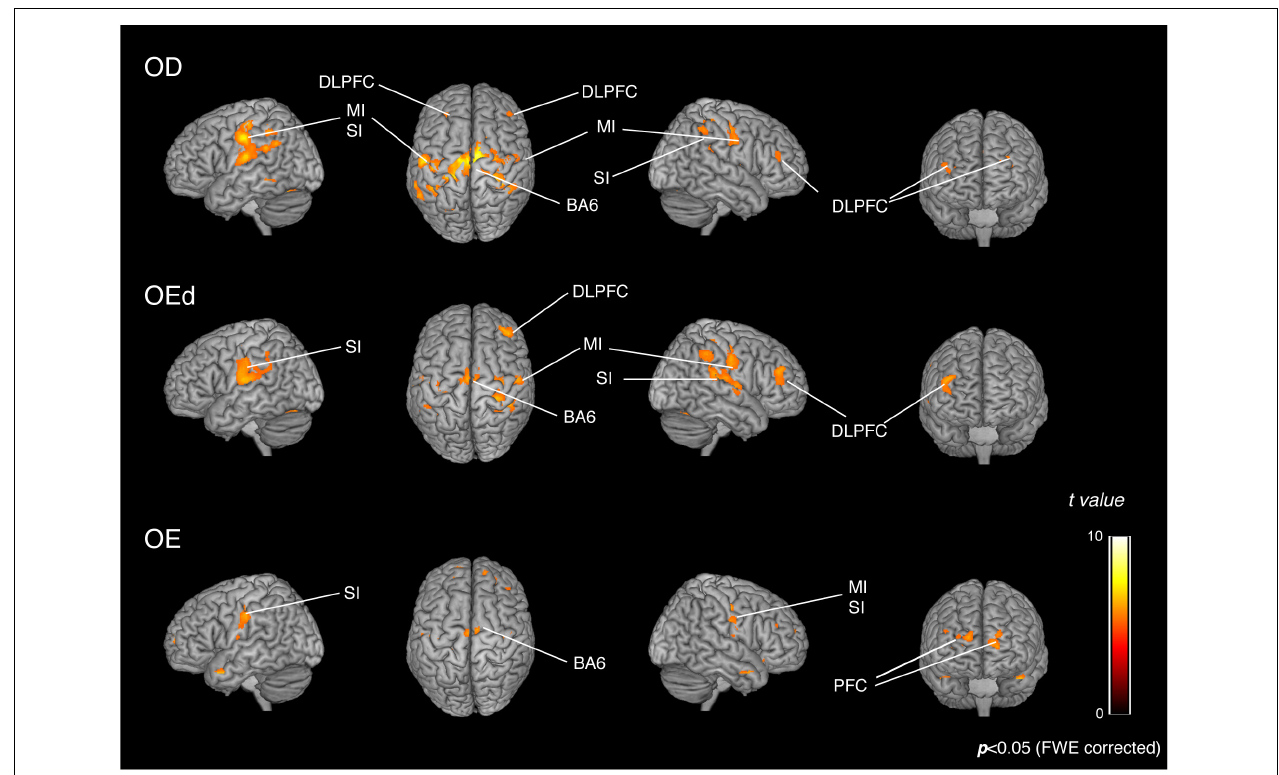
FIGURE 3 | Teeth tapping induced activated regions on the cortex in the OD (top) , OEd (middle) , and OE (bottom) groups. Surface projection of statistical parametric maps (GLM analysis) superimposed onto a standard MNI template brain ( p < 0.05, FWE corrected). The color bar shows the t -values. Teeth tapping activated various foci, including the sensorimotor cortex, BA6, and prefrontal